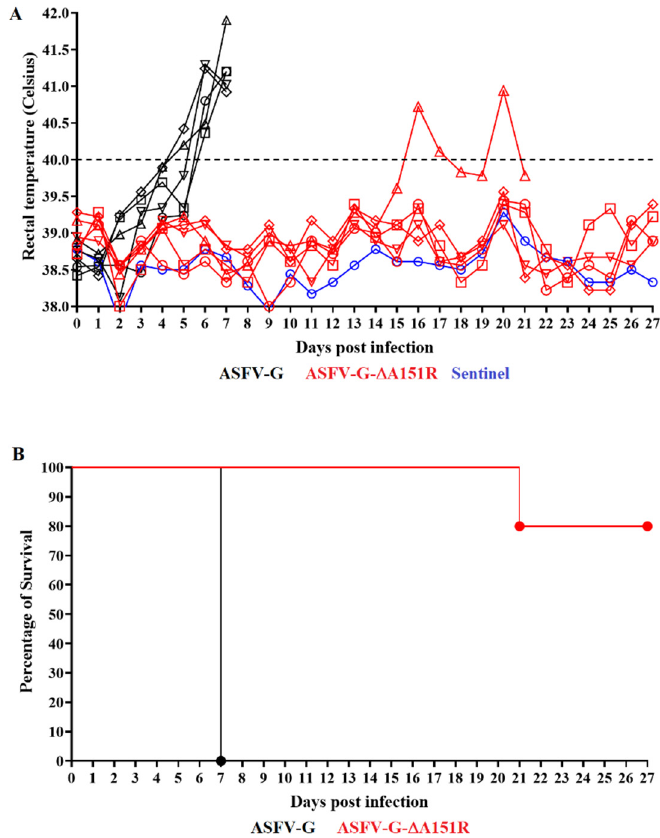
Figure 5. Evolution of body temperature ( A ) and mortality ( B ) in animals (5 animals/group) IM infected with 10 2 HAD 50 of either ASFV-G- ∆ A151R or parental ASFV-G.